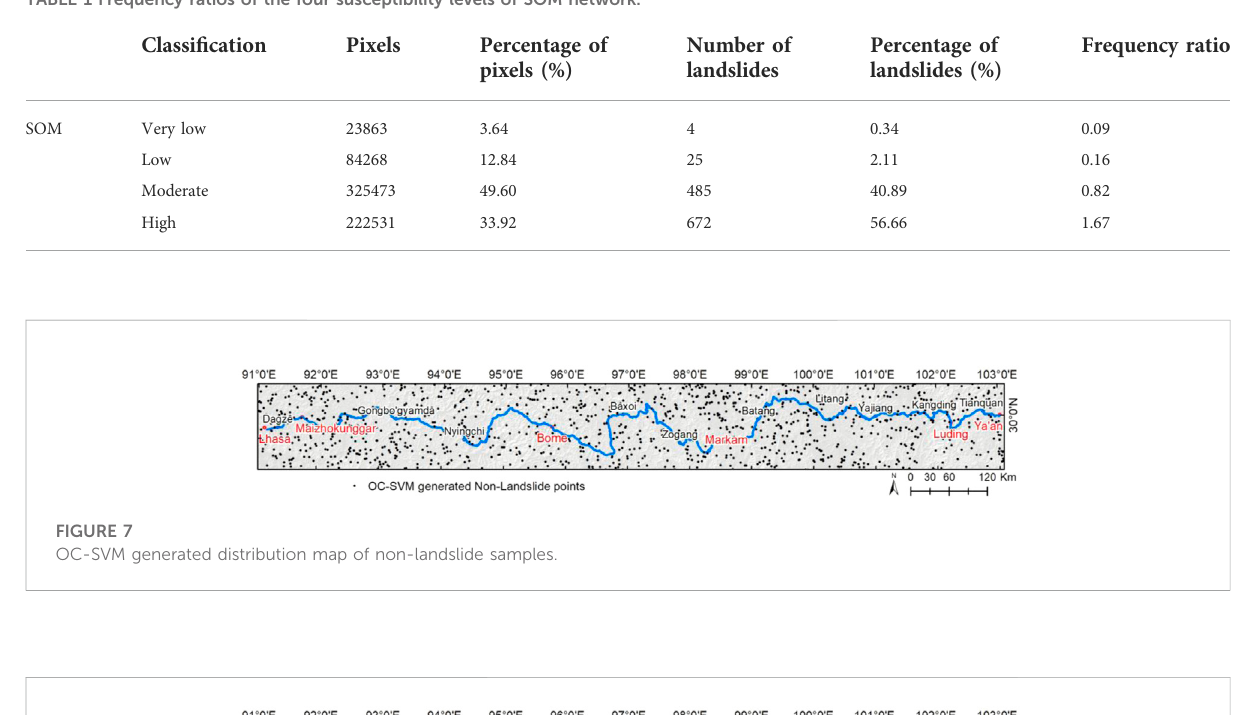
TABLE 1 Frequency ratios of the four susceptibility levels of SOM